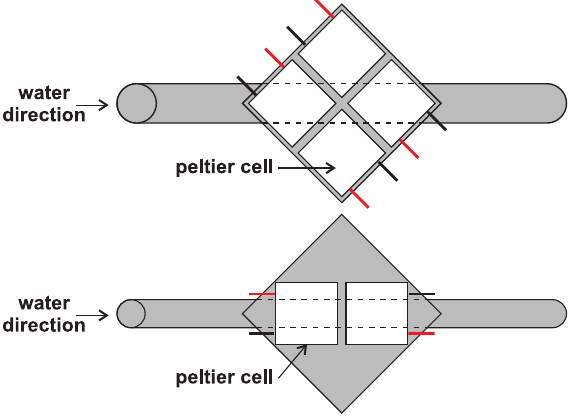
Figure 6. Experimental setup for placement of more cells: ( Up ) Four cells; ( Down ) Two